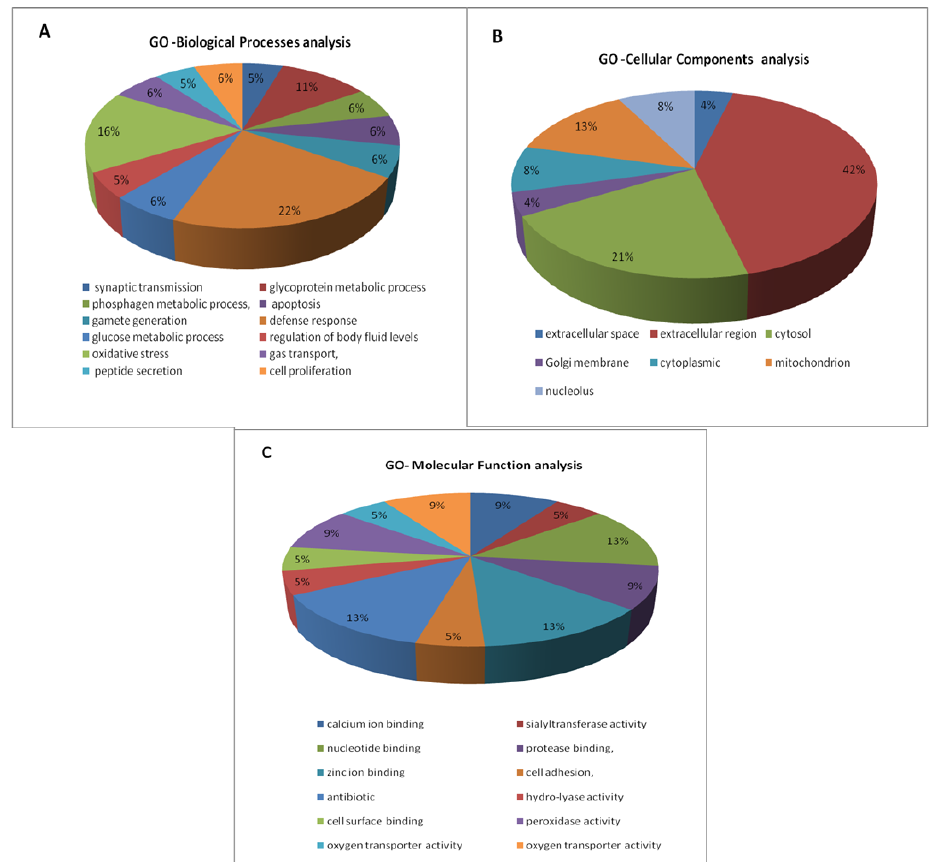
Figure 6. Pie diagrams of the proportion of differentially expressed epididymal proteins categorized by function between the dutasteride group and control group. ( A ) Gene Ontology analysis for biological processes; ( B ) Gene Ontology analysis for cellular components; ( C ) Gene Ontology analysis for molecular function.